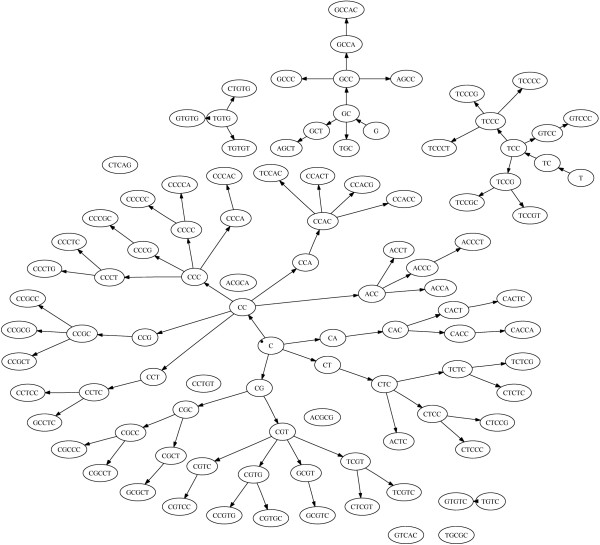
Subword Structure of Effective Subword-unique Motifs. A subword tree illustrating the makeup of the subword-unique motifs associated with antisense effectiveness. A motif is linked with an arrow to another if the motif at the tail of the arrow is a submotif of the one at the head that differs only by the addition of one base to the beginning or the end. For example, "CC" would be at the tail of an arrow connecting it to either "CCG" or "GCC", but there would be no arrow connecting it to "CGC" or "GGCC". For motifs associate with antisense effectiveness, the majority of significant motifs are linked in a tree with "C" as the root node.